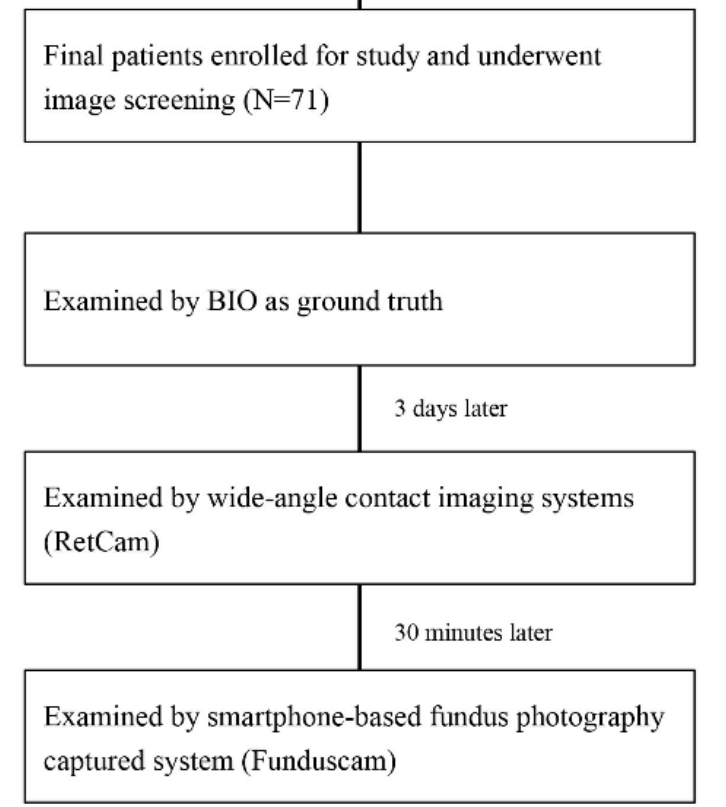
Figure 1. Flow chart and examinations performed in this study.